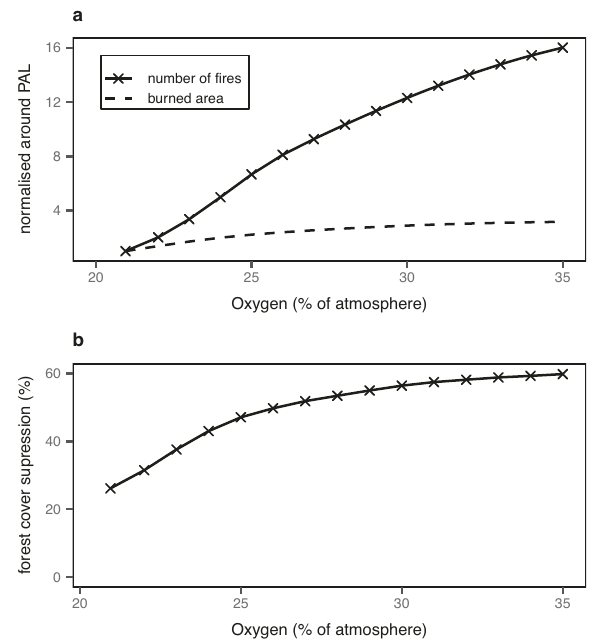
Fig.2|Flammabilityandforestcover fi resuppressionoutputfromsimulations over atmospheric oxygen. Output from LPJ-LM fi re shown as total global 10-year averages over varying atmospheric oxygen levels showing a number of fi res (solid line) & burned area (dashed line) and b forest cover suppression de fi ned as the percentage decrease from a world with no fi